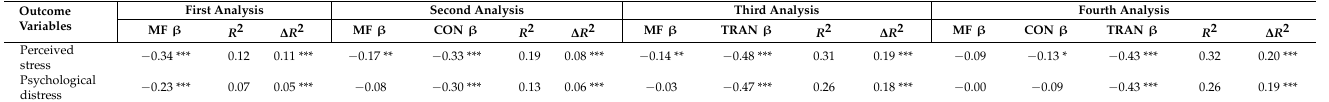
Table 3. Incremental value of concentration and tranquility over the cross-sectional effect of mindful- ness on outcome variables: results of cross-sectional hierarchical multiple regression analyses ( n = 333).